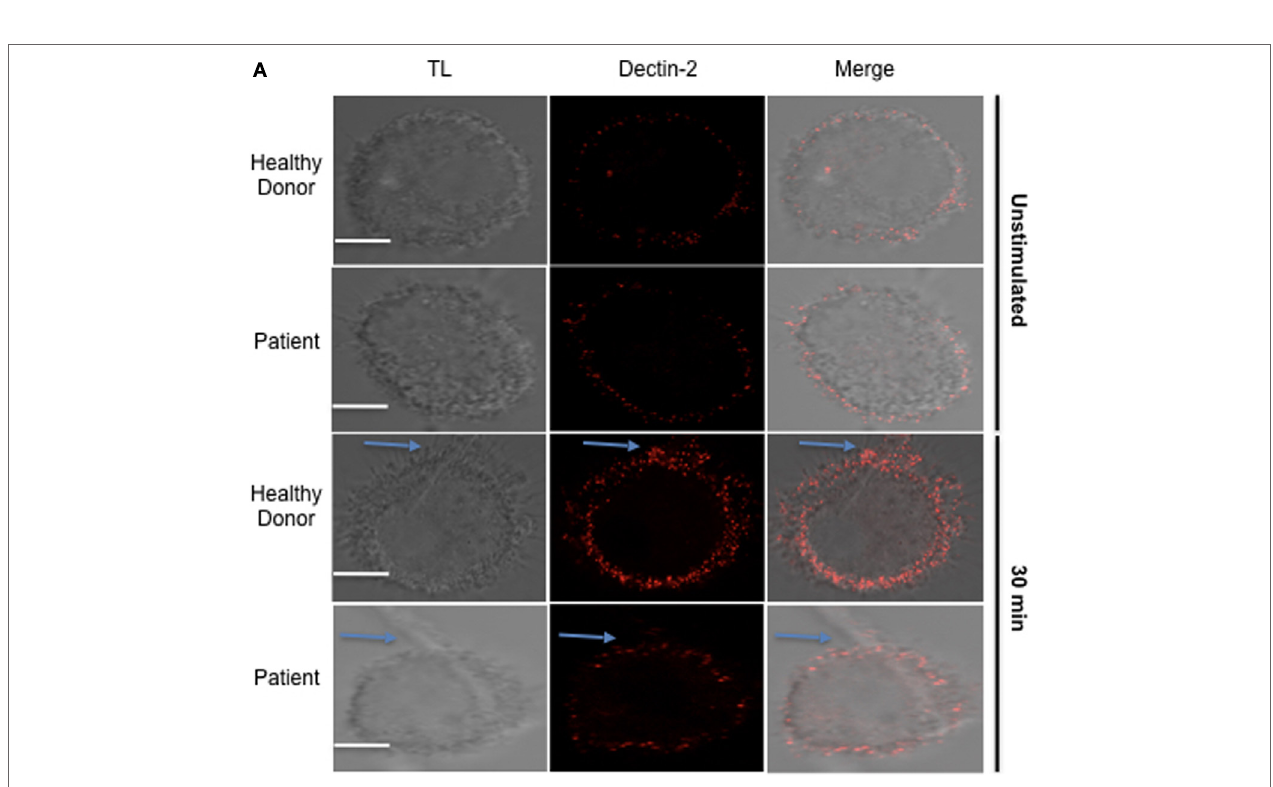
FigUre 5 | Candidacidal activity in wild-type and AIRE-knockdown macrophage-like THP-1 cells. Wild-type and AIRE-knockdown macrophage-like THP-1 cells were stimulated with yeast [multiplicity of infection (MOI 1:2)] (B) or hyphae (MOI 2:1) GFP C. albicans (c) for 20 or 30 min. (a) Image Stream analysis of fungal phagocytosis by macrophages. GFP fluorescence intensities were gated for further analysis. The cells were divided into subpopulations according to the GFP maximum pixels. Internalization gate was performed for cells incubated with yeast or hyphae at 4°C. Each dot represents one independent experiment used for the measurement indicated. Wild-type (blue circle) and AIRE-knockdown macrophage-like THP-1 cells (red square). (D,e) Measurement of cytoplasm acidification in wild-type and AIRE-knockdown macrophage-like THP-1 cells stimulated with yeast (MOI 1:2) (D) or hyphae (MOI 2:1) (e) for 20 or 30 min by Image Stream analysis. Representative images of five independent experiments are shown. (F) IL-1 β and TNF- α secretion in supernatants from resting and hyphae-stimulated cells. Wild-type (black bar) and AIRE-knockdown (gray bar) macrophage-like THP-1 cells were stimulated with hyphae (MOI 2:1) for 6 h. The horizontal bars denote the mean. Representative graph of three independent experiments. * p < 0.05 as determined by the t